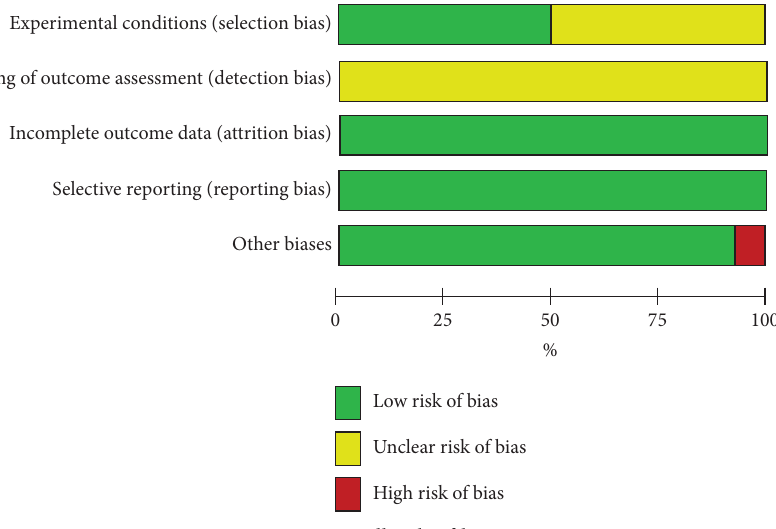
Figure 2: Overall risk of